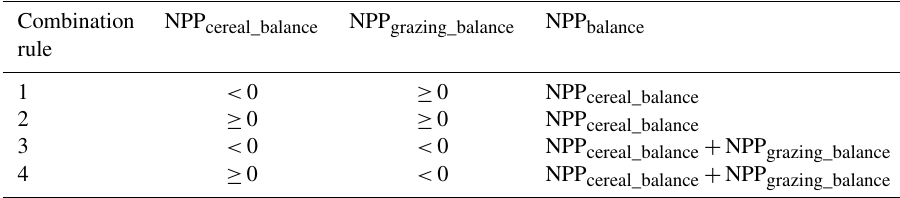
Table 2. Rules of combining NPP cereal_balance and NPP grazing_balance to determine the final balance of NPP demand and supply.